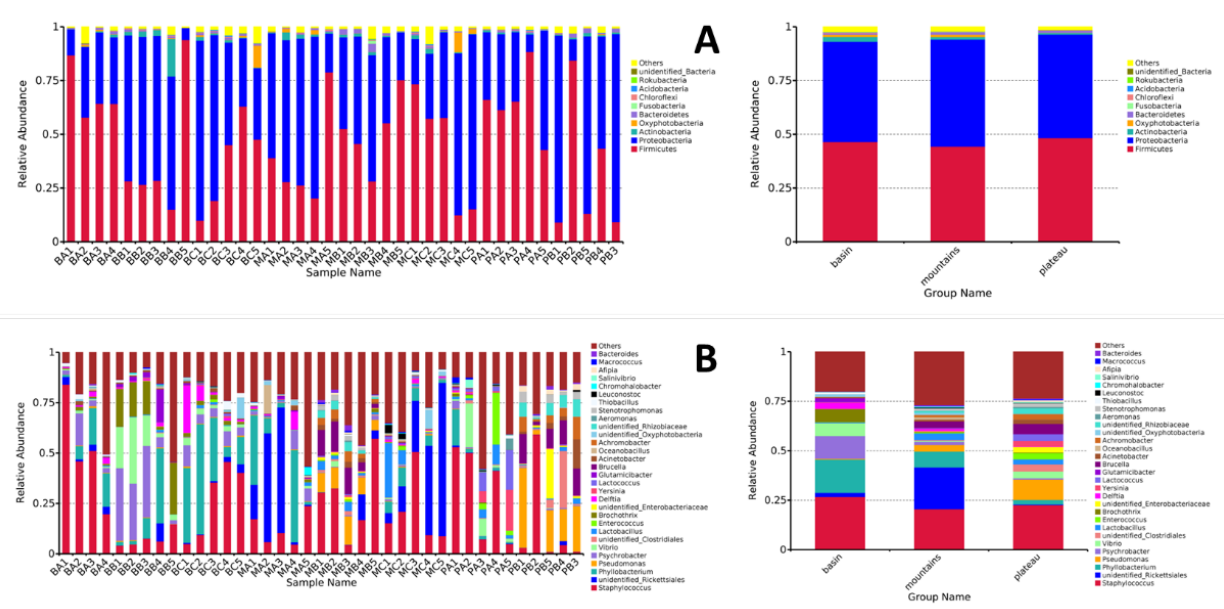
Figure 2. The relative abundances of bacterial compositions of different bacons ( A ) at the phylum level and ( B ) at the genus level.